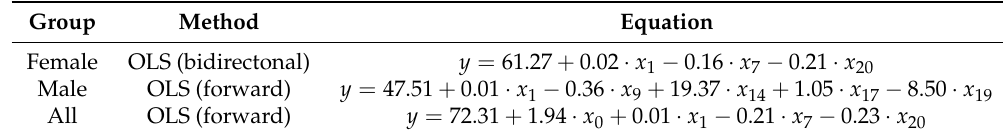
All—all participants, F—female, M—male, Lasso—ordinary least squares regression, OLS—ordinary least squares regression, MLP—multilayer perceptron, RBF–artifical nural network with radial basis function. Table 5. VO 2 max linear predictive